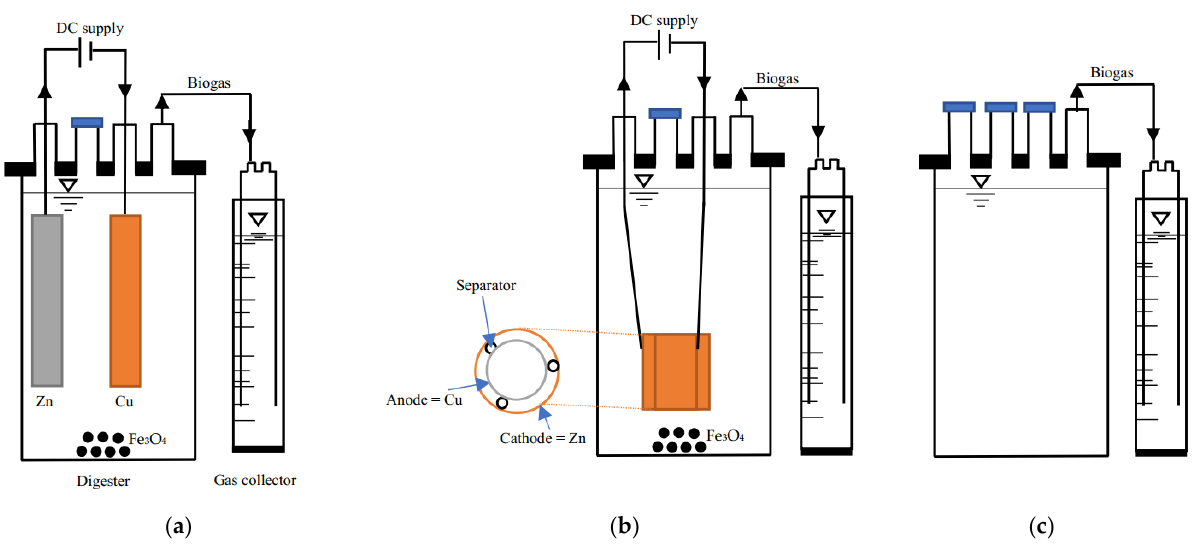
Figure 11. Drawing of anaerobic digestion: ( a ) rectangular microbial electrolysis cell (MEC); ( b ) cylindrical microbial electrolysis cell (MECC); and ( c ) control.